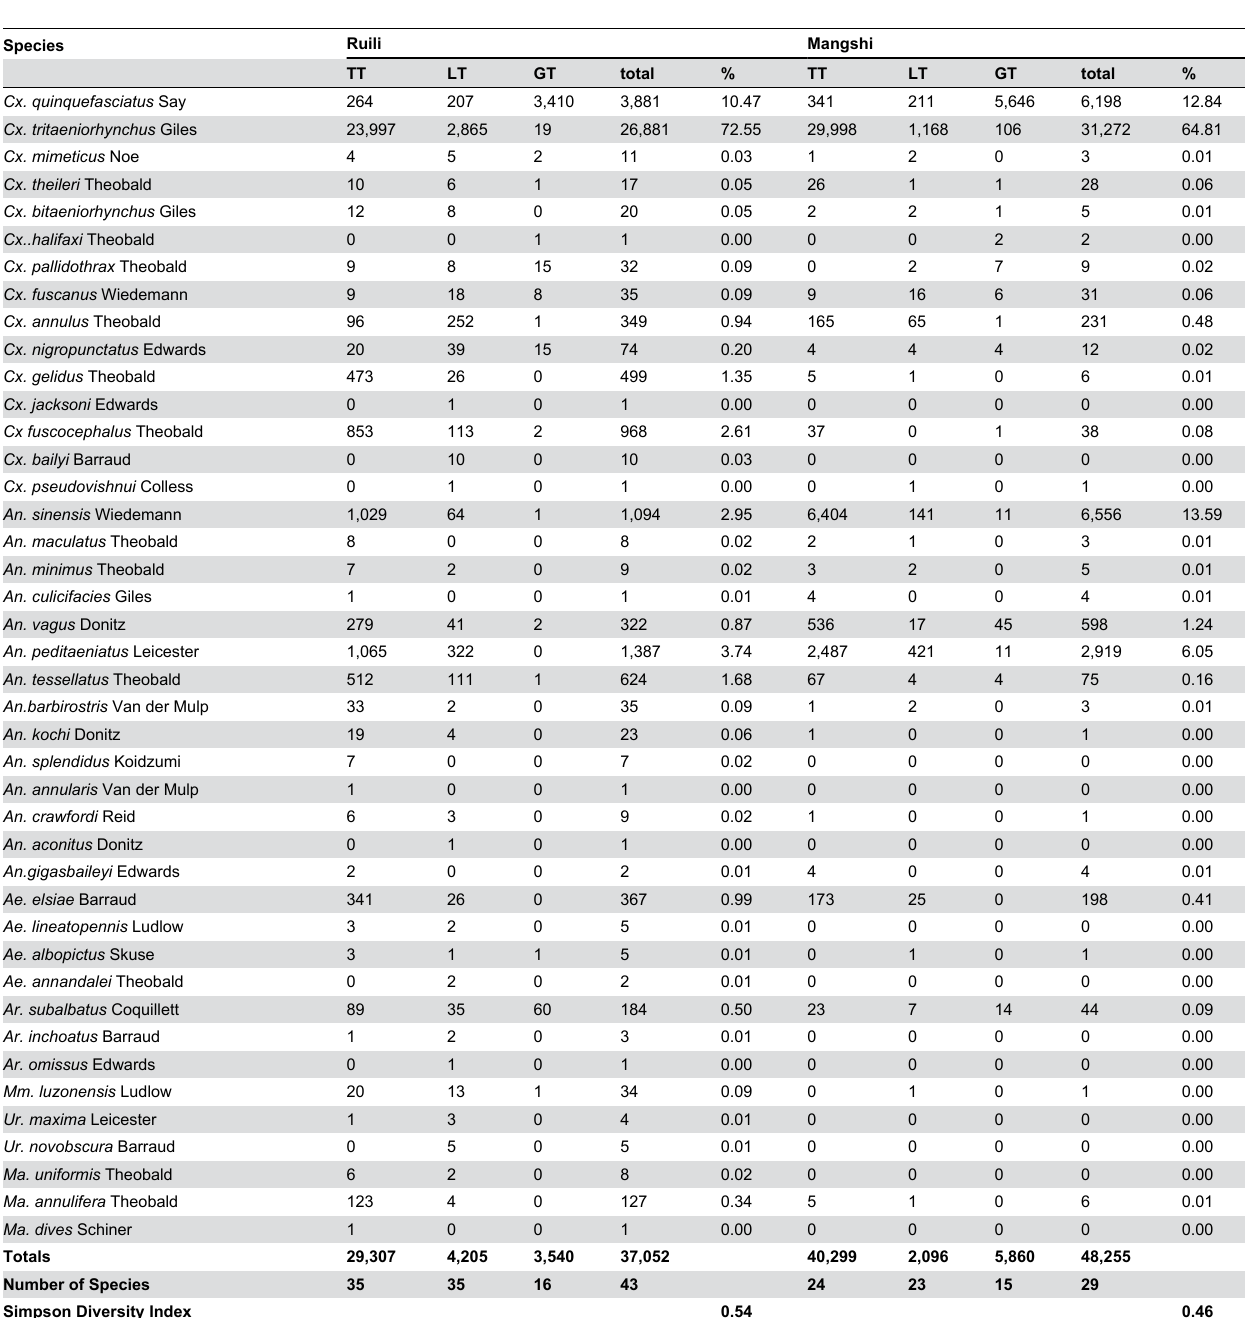
Table 3. Summary of mosquito species collected in Mangshi and Ruili during Jan-Dec, 2010.